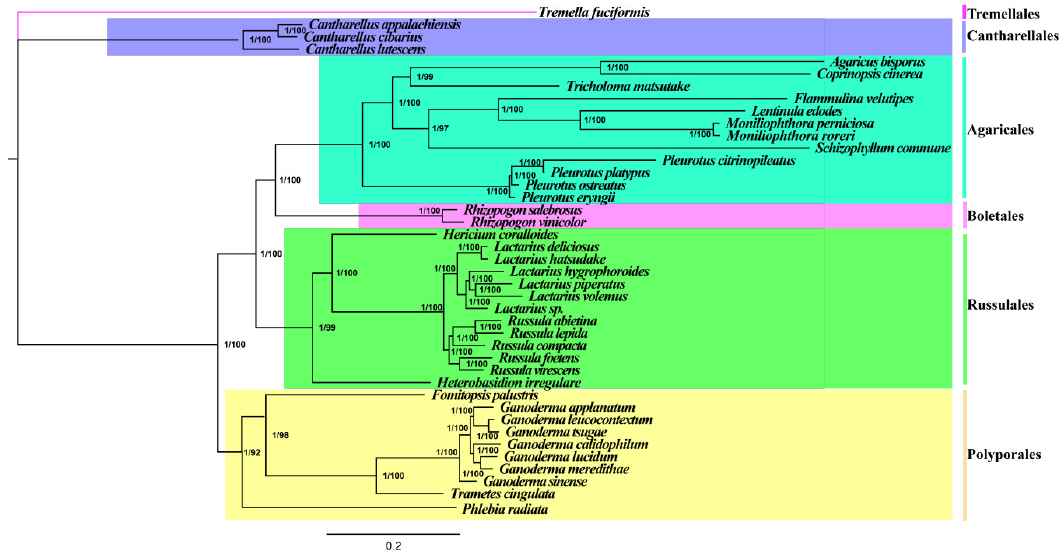
Figure 7. Molecular phylogeny of 41 Agaricomycotina species based on Bayesian inference (BI) and Maximum likelihood (ML) analysis of 15 protein coding genes and two rRNA genes. Support values are Bayesian posterior probabilities (before slash) and bootstrap (BS) values (after slash). Species and NCBI accession numbers for genomes used in the phylogenetic analysis are provided in Supplementary Table S9.